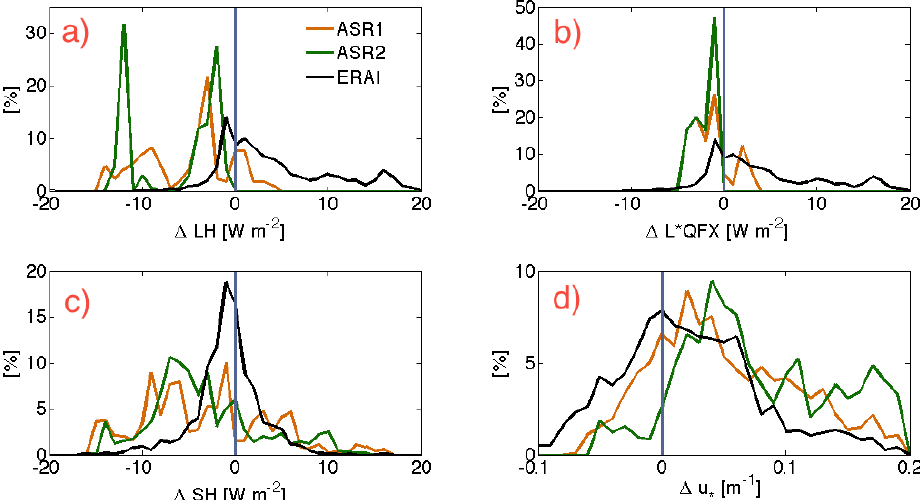
Fig. 16. Histograms (%) of the difference between each reanalysis respectively and the ASCOS observations for the variables in Fig. 15: (a) latent heat flux at the surface (LH); (b) moisture flux times the latent heat of vaporization at 0 ◦ C (L ∗ QFX); (c) sensible heat flux (SH) in Wm − 2 ; and (d) the friction velocity, u ∗ , in ms − 1 .